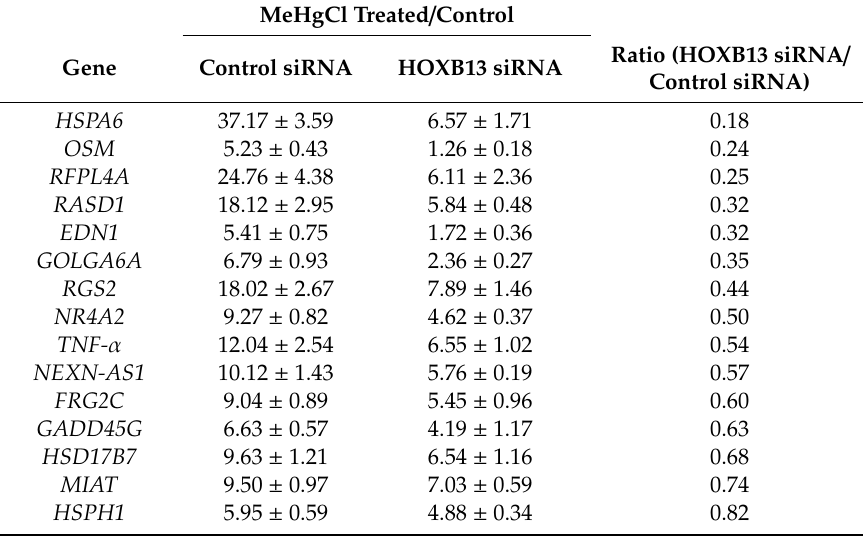
Table 1. Gene expression induced by methylmercury via homeobox protein B13